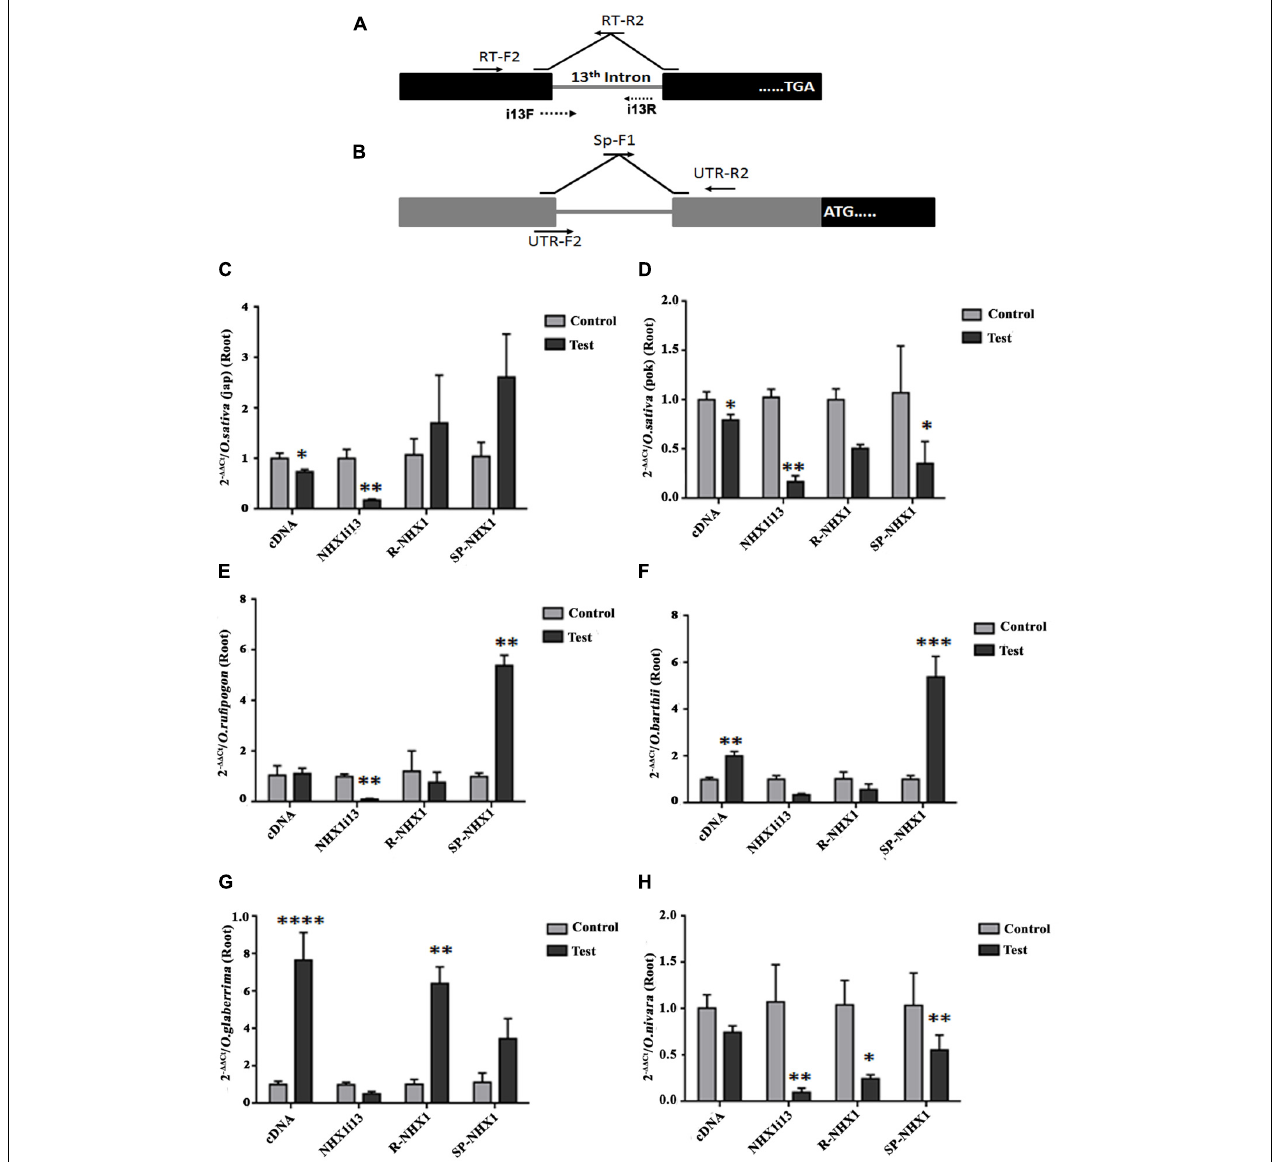
FIGURE 8 | qRT-PCR expression analysis of NHX1 splice variants in Oryza spp. root tissues under salinity. (A,B) Same as in Figures 7A,B . (C–H) Oryza spp. examined: O. sativa [ssp. japonica (C) ] , O. sativa [ssp. indica cv. Pokkali (D) ] , O. rufipogon (E) , O. barthii (F) , O. glaberrima (G) , O. nivara (H) . All qRT-PCRs for